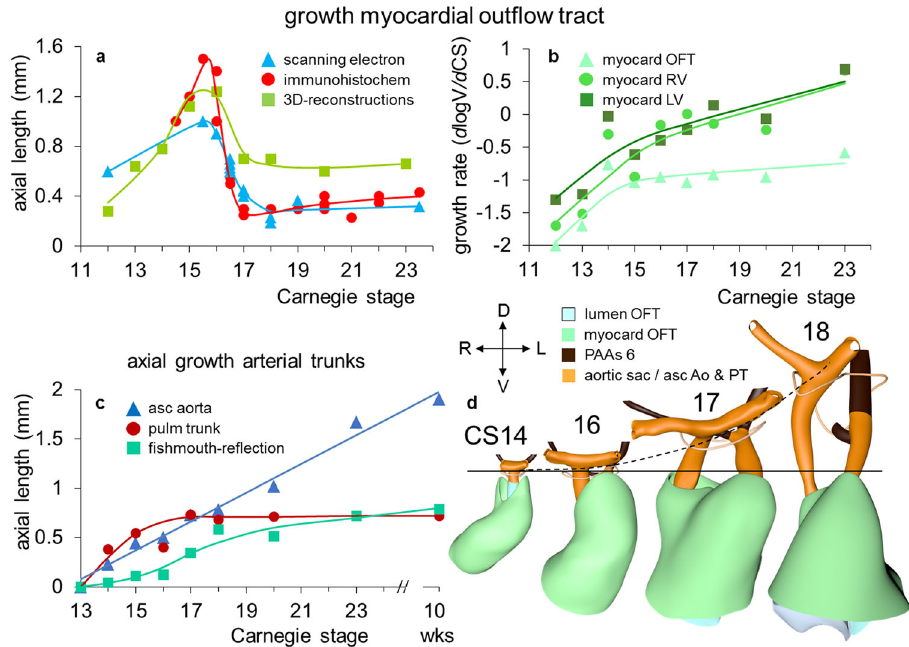
Fig. 6 Changes in size and shape of the myocardial out fl ow tract and arterial trunks. The left-sided graph ( a ) shows the length of the muscular out fl ow tract between the proximal and distal ends of the endocardial out fl ow ridges. The green square symbols represent the measurements made in our reconstructions, with the blue triangular symbols taken from measurements made in 14 scanning electron microscopic images 154 , and the red circular symbols representing those made in 18 immunohistochemically stained and partially reconstructed hearts 203 . Each dot in the graphs represents a single embryo. There is axial growth of the muscular out fl ow tract up to CS16, when its length suddenly declines profoundly, with no resumption up to CS23. The right-sided graph ( b ) shows the change in volumetric growth rate of the myocardium of the out fl ow tract (light green triangles), right ventricle (green circles), and left ventricle (dark green squares). The growth rate in all three compartments declines at CS15, with the growth of the out fl ow tract being practically nonexistent. The lower left graph ( c ) shows the axial growth of the arterial trunks. The ascending aorta (blue triangles) increases continuously in length between CS14 and 10 weeks of development, whereas axial growth of the pulmonary trunk (red circles) stops after CS17. The distance between the distal myocardial border and the pericardial re fl ection (green squares) increases little to CS16, indicating that the myocardial jaws of the fi shmouth stay close to the pericardial re fl ection, whereas the myocardial border moves away from the re fl ection concomitant with the abrupt shortening of the myocardial out fl ow tract after CS16. Panel d shows cranial views of the myocardial out fl ow tract, the arterial trunks, and the pericardial re fl ection (wire loop) to visualize the axial growth of the aortic trunk (dashed line). The images are aligned to the distal myocardial border of the out fl ow tract (black line), with the fi shmouth representing the lateral indentations of the distal myocardium between CS14 and CS16. The slits in the jaws of the myocardial fi shmouth are occupied by the non-myocardial mural columns (see Fig. 8a – e). The 6th arch arteries (dark brown) stem from the pulmonary trunk, while the ascending aorta is recognizable by its lateral “ horns ” . All images are also available as preset views in the corresponding cuff at CS13, reorganizes distally into four orthogonal columns, while only two columns persist proximally (Fig. 7a – g).